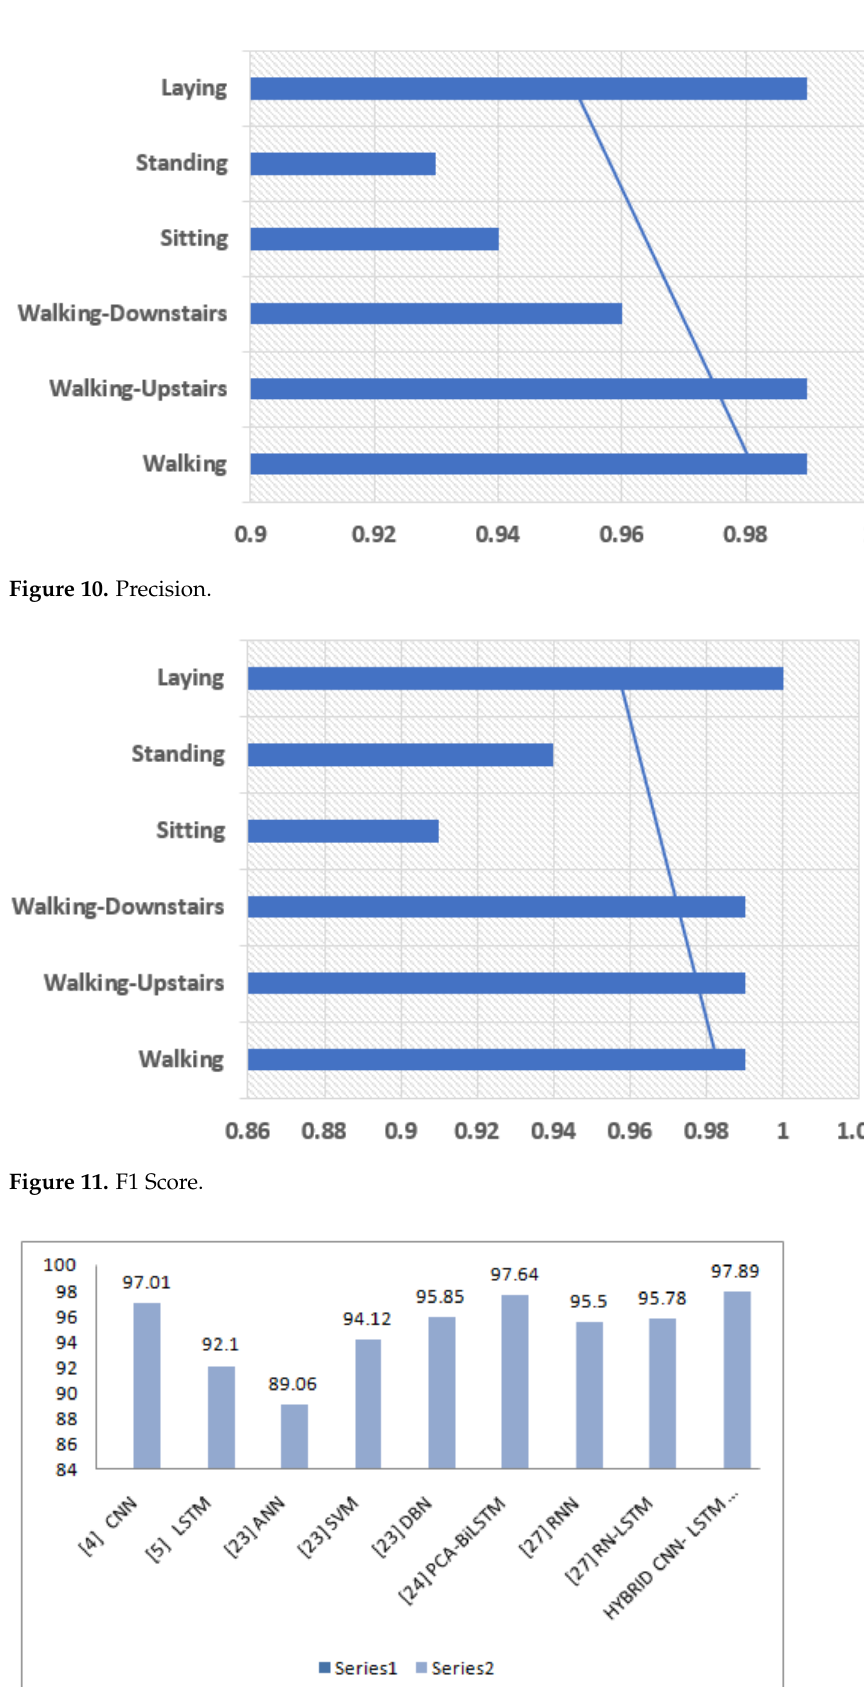
Figure 12. Comparison of accuracy of proposed model with state of art models considered as sequence required for input in kernel size used to read or processed the 448 learning features. For the network optimization an efficient method known as gradient 449 descent is being used. The requirements for a model to be fit for a fixed number of 450 epochs 10, batch size of 32 samples, exposure of 32 windows of data but before the 451 models weight updation. The graph between human physical activities with precision 452 values and the f1 score the results can be shown in Figure 10 and Figure 11. The precision 453 parameter showing the more precise results in Walking, Walking Upstairs and Laying. 454 The F1-Score values showing the best results in Walking, Walking Upstairs, Walking 455 Downstairs and Laying. By discussing the following parameters makes the model fit to 456 use. Once the model is fit, can be evaluated on the test dataset and then returns with 457 the accuracy of the fit model on the test dataset. Our model is the best fit giving the 458 best accuracy of 97.89%. The Table 4 is showing the comparison among our proposed 459 model’s accuracy with that of the existing related work done. 460